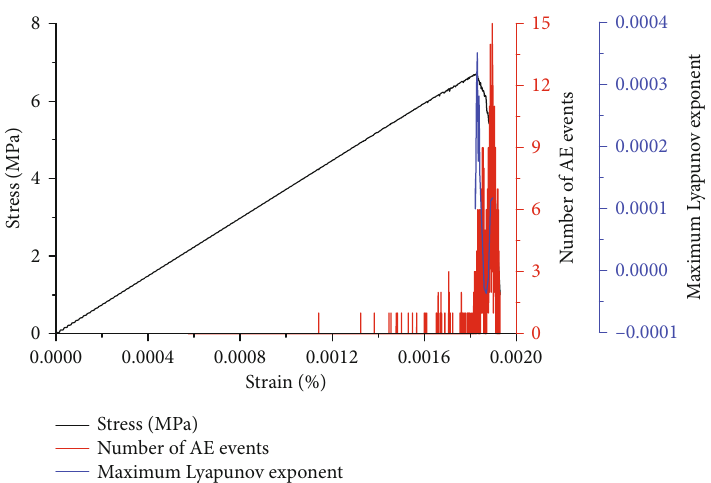
Figure 7: Stress-strain-number of AE events-maximum Lyapunov exponential variation diagram of specimen 4.